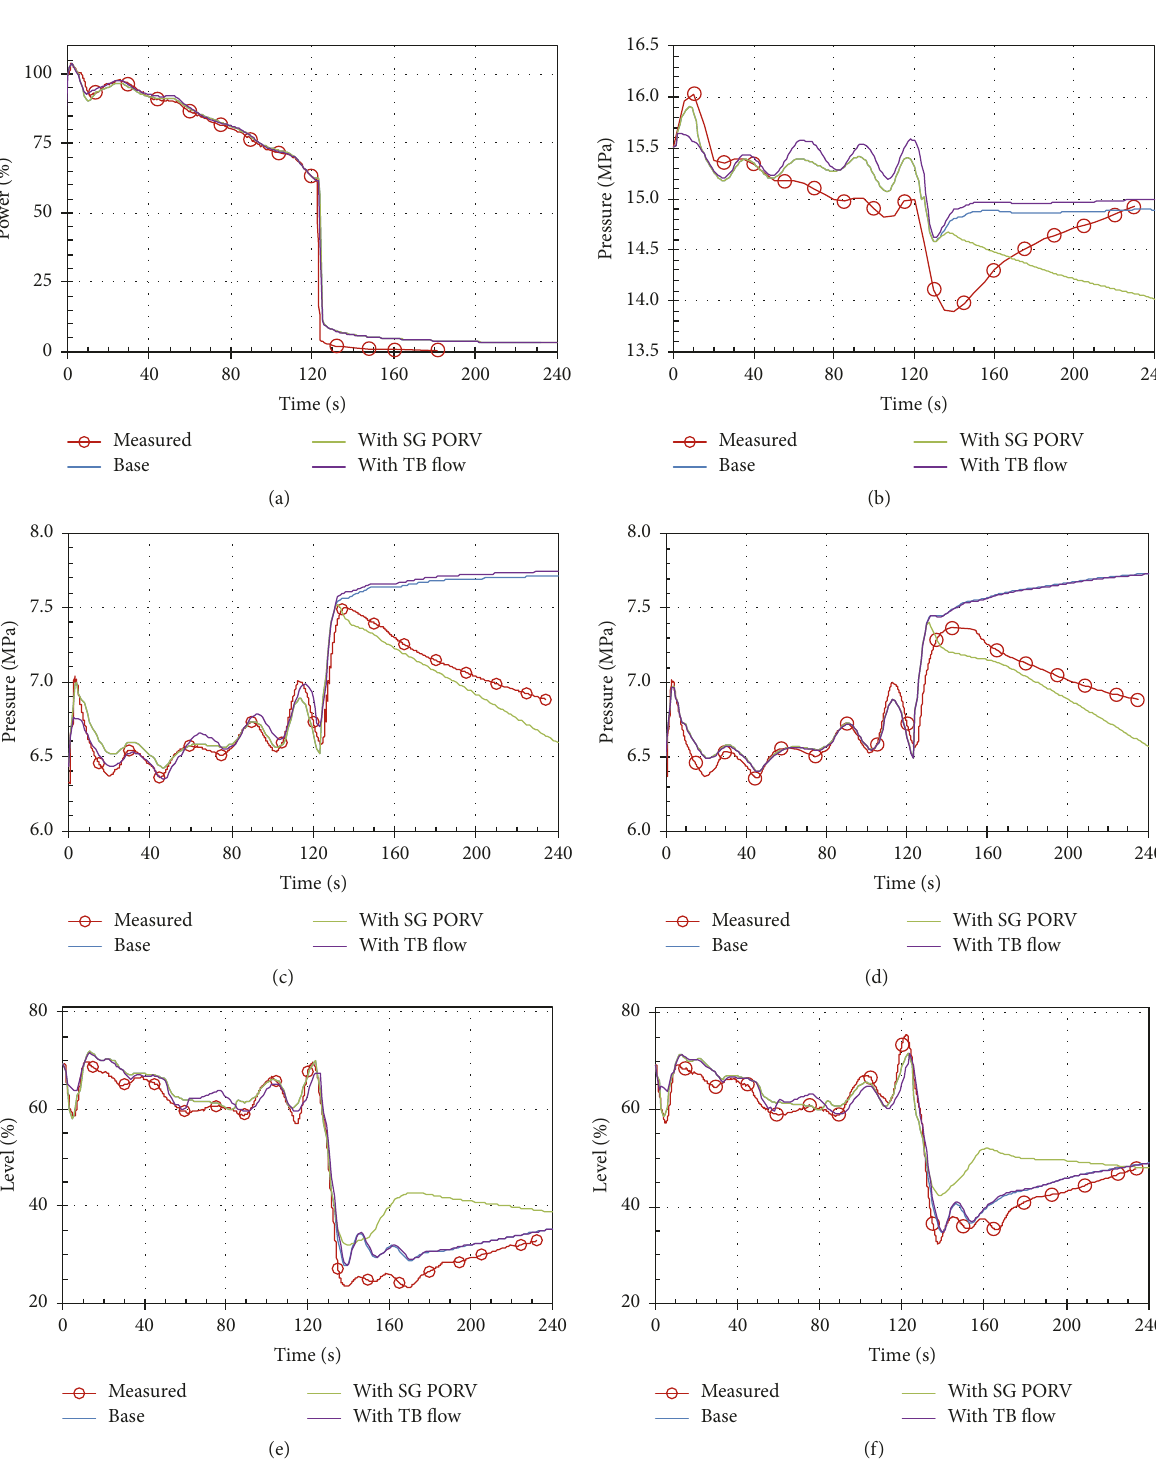
Figure 11: Second part: (a) reactor power; (b) pressurizer pressure; (c) SG number 1 pressure; (d) SG number 2 pressure; (e) SG number 1 narrow range level; (f) SG number 2 narrow range